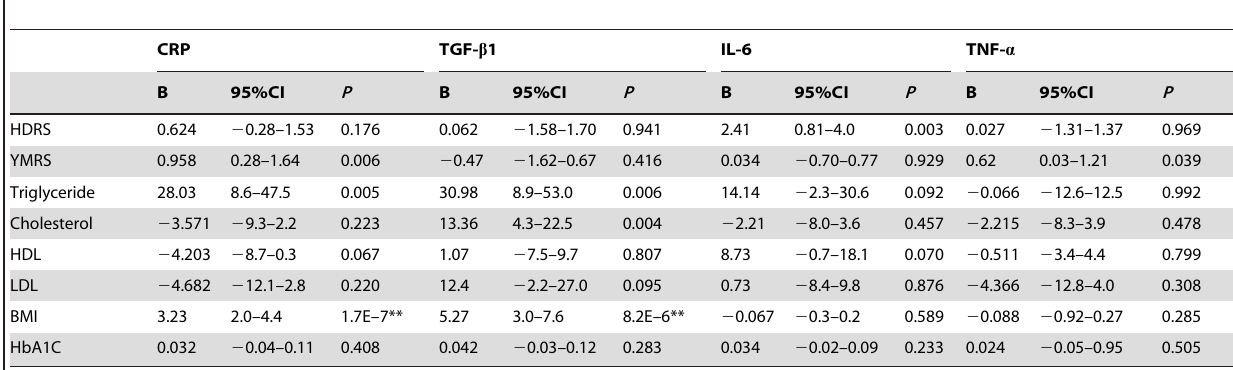
Table 2. Correlation of changes in metabolic profiles and cytokines before and after 12 weeks of pharmacological treatment.